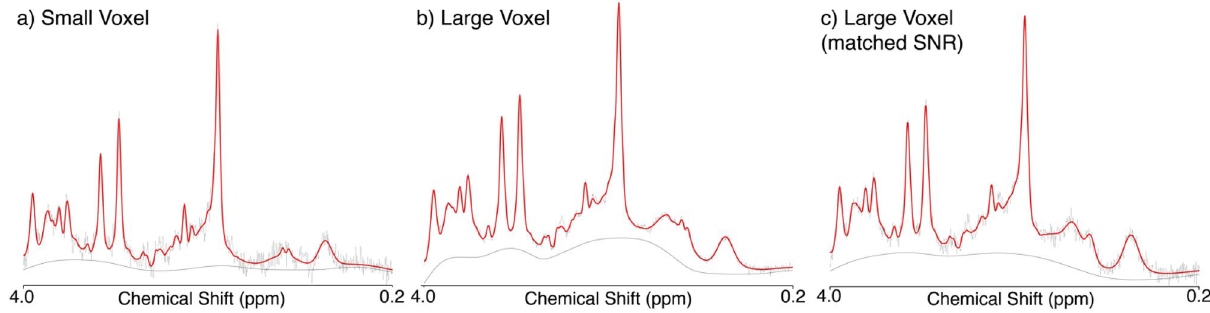
Figure 2. Exemplar spectra from one participant for the ( a ) small voxel, ( b ) large voxel with full signal, and ( c ) large voxel with reduced